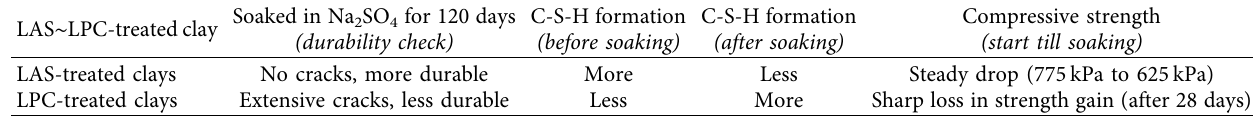
Table 6: Comparison of lime-activated GGBS (LAS) and lime-activated Portland cement (LPC), in perspective of stabilization. Soaked in Na 2 SO 4 for 120 days LAS ∼ LPC-treated clay (durability